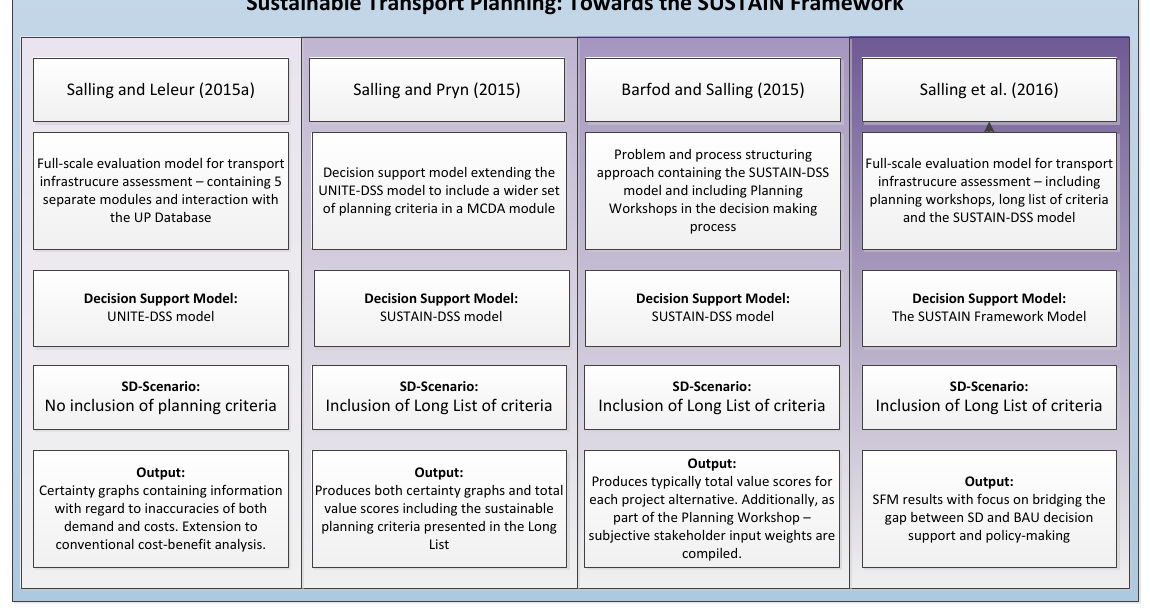
Figure 9. Overview of the development stages of the SUSTAIN Framework